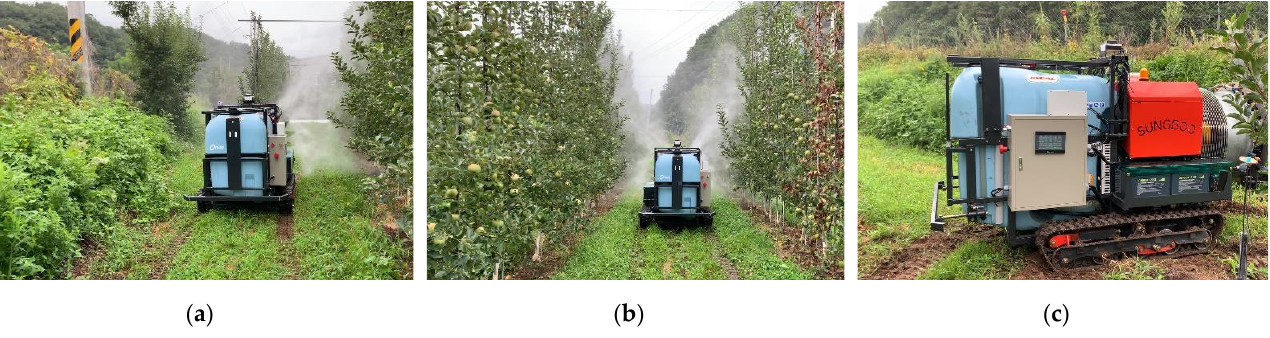
Figure 10. The speed sprayer operating during the first test of the autonomous driving-based spraying. ( a ) Left spraying zone, ( b ) Left and right spraying zone, ( c ) No spraying zone (rotation section).